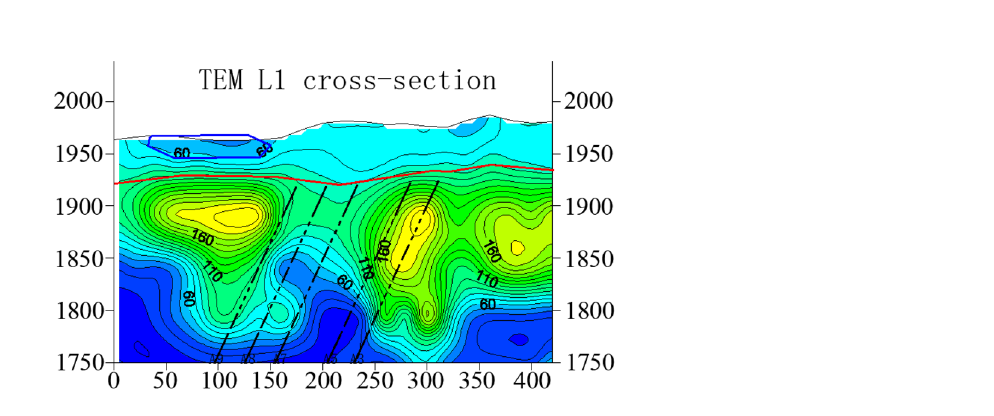
Figure 7. The resistivity profile of the TEM of